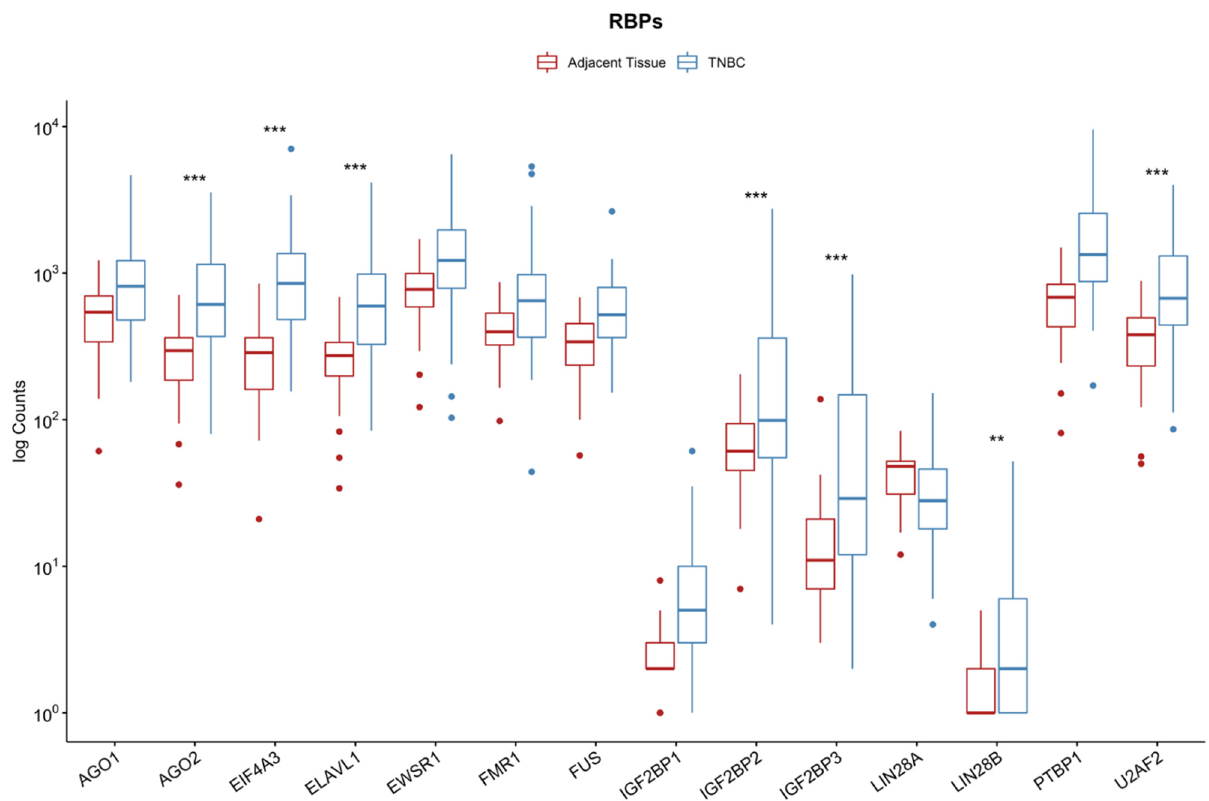
Figure 2. Gene expression of the RNA binding proteins (RBPs) predicted to interact with hsa_circ_0072309, circ_0004365, circ_0006677, circ_0008599, circ_0009043, and circ_0000479. ** p < 0.01, *** p < 0.001.